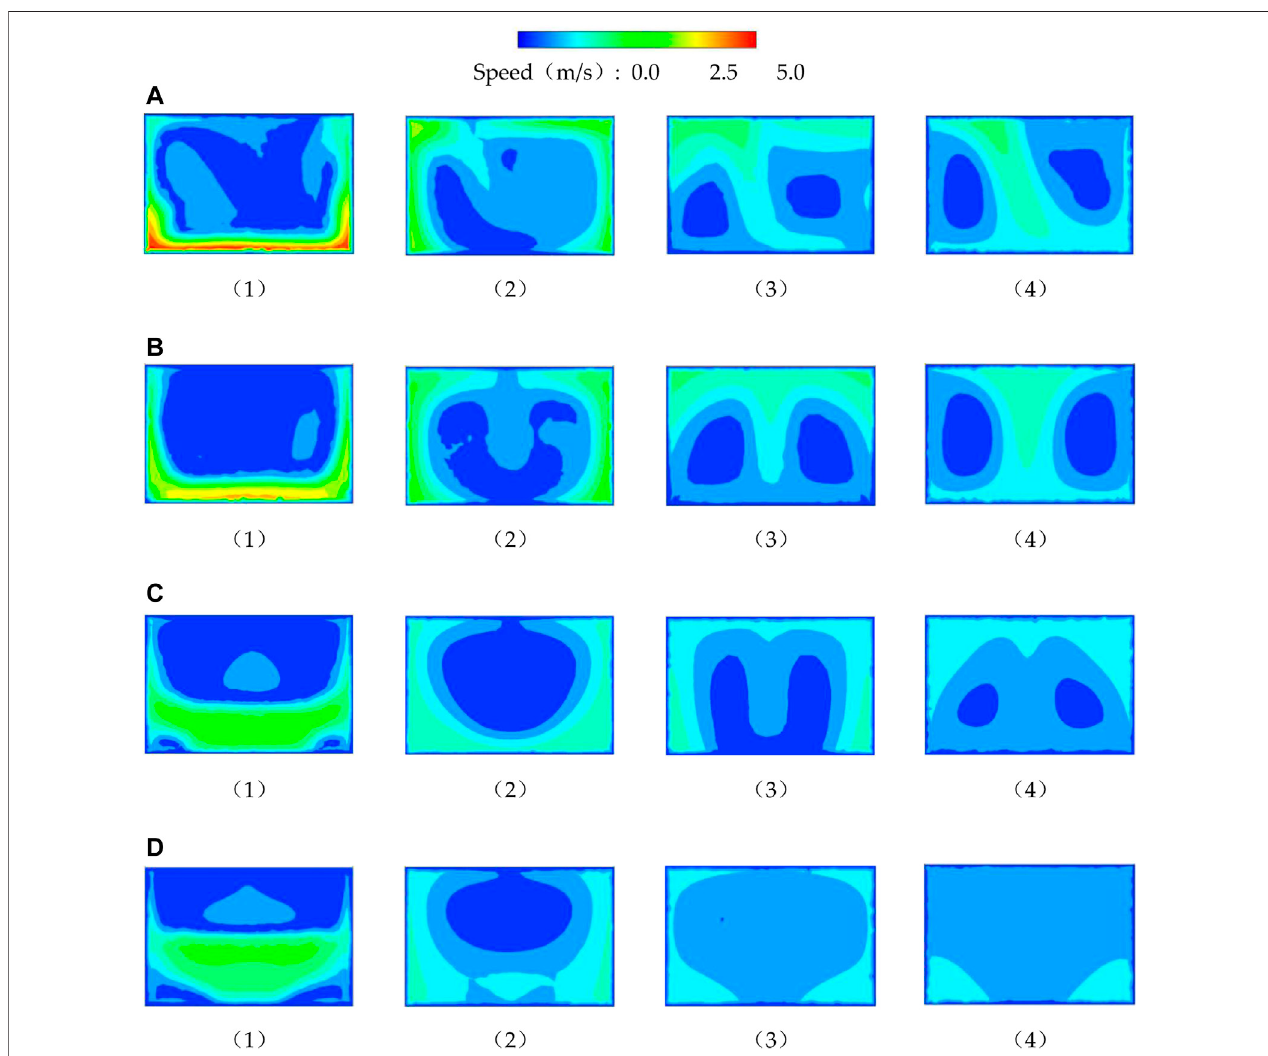
FIGURE 11 | Flow fi eld distribution of axial sections: (A) case 1, (B) case 2, (C) case 3, and (D) case 4.